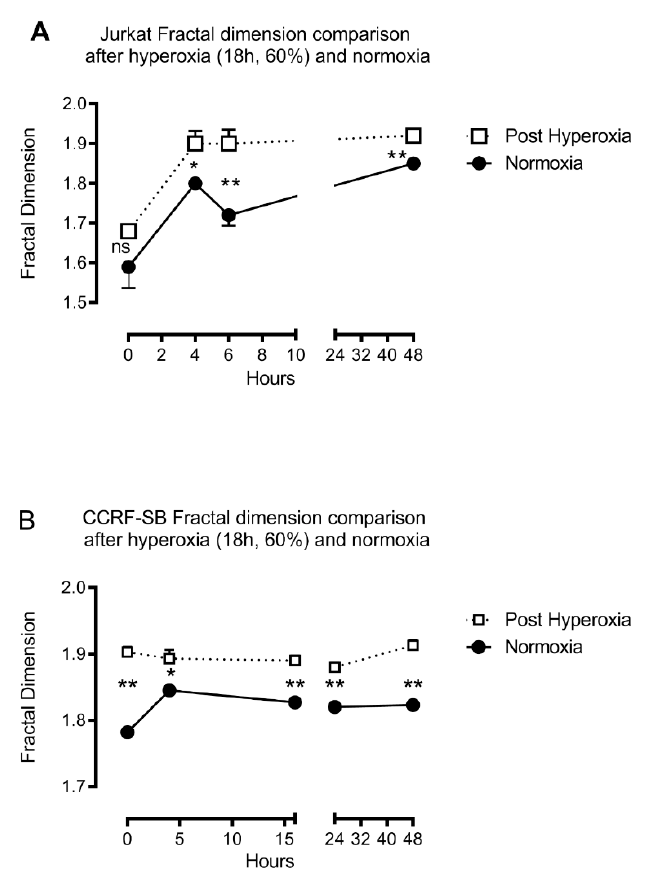
Figure 7. Comparison of the fractal dimensions of JURKAT ( A ) and CCRF-SB ( B ) cells over time after 18 h of hyperoxic exposure as compared to normoxia. Cells were in the same culture medium and were monitored for 48 h, ** = p < 0.01.